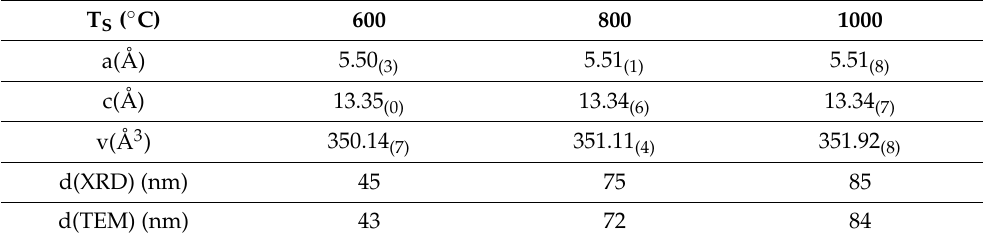
Table 1. Structural parameters of the La 0.9 Sr 0.1 MnO 3 system sintered at 600, 800, and 1000 ◦